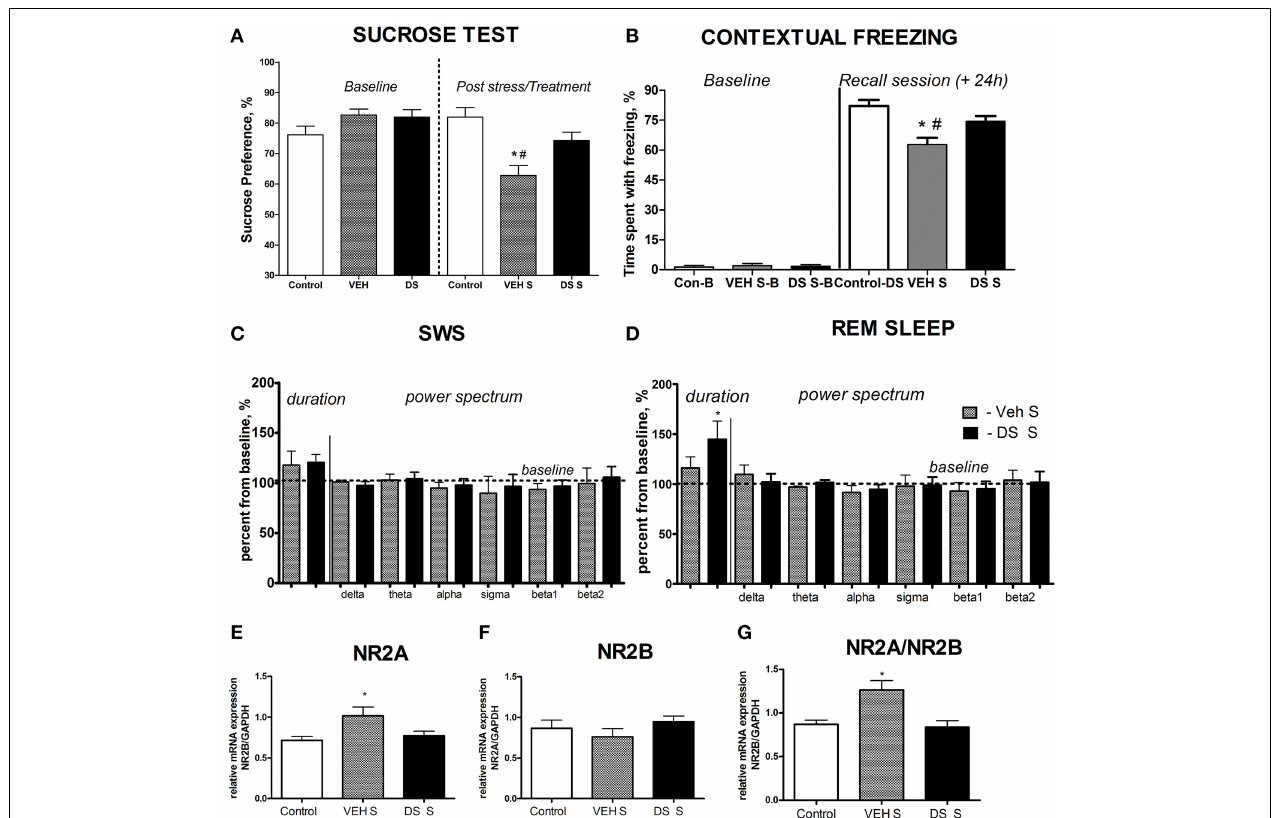
FIGURE 2 | Effects of Dicholine Succinate in a chronic stress model. (A) Sucrose preference was significantly lowered in stressed vehicle treated animals as compared to their controls as well as to DS-treated stressed mice ( p < 0 . 001 vs. control and DS respectively). (B) In contextual fear conditioning, the percentage of time spent with freezing during a baseline (pre-training) period was similarly low in all experimental groups ( p > 0 . 05). The vehicle stressed group showed memory loss as indicated by significantly lesser freezing compared to both non-stressed controls ( p < 0 . 01) and DS treated stressed mice during a recall session that was evaluated 24h after a baseline measurement and a training session ( + 24h) p < 0 . 01. (C) Slow wave sleep was not different between the not treated stressed or DS treated stressed groups ( p > 0 . 05).